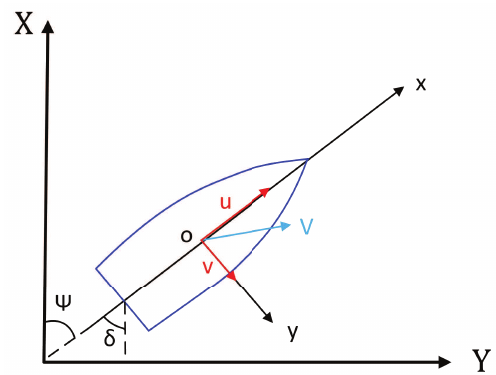
Figure 5. Schematic diagram of plane motion.